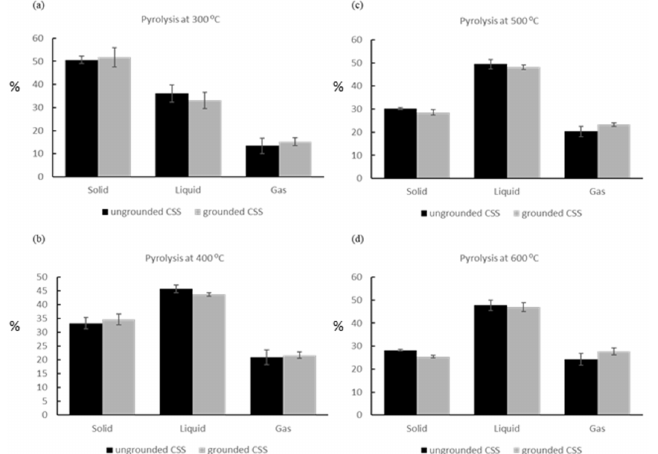
Figure 6. Comparison of solid, liquid, and gas fractions (wt.%) in the pyrolysis of ungrounded and grounded CSS at all the temperatures tested: ( a ) 300 °C; ( b ) 400 °C; ( c ) 500 °C; and ( d ) 600 °C.